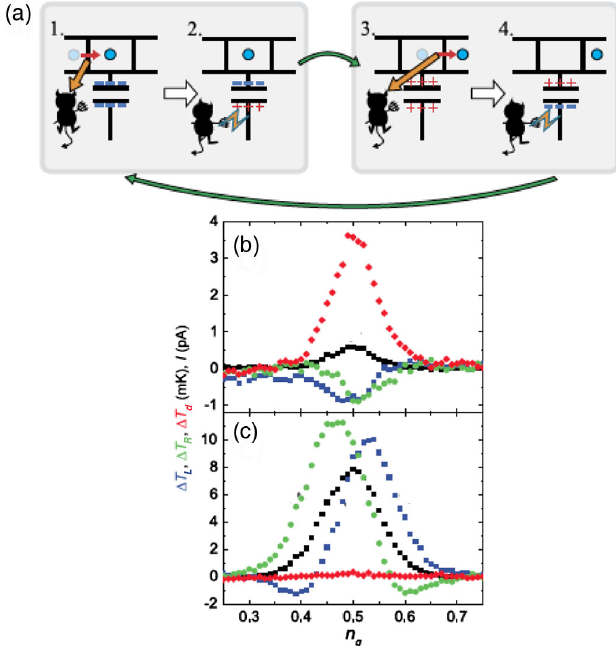
FIG. 15. (a) Principle of the experimental realization of the autonomous Maxwell ’ s demon. The horizontal top row schema- tizes a single-electron transistor. Electrons (blue circle) can tunnel inside the central island from the left wall and outside from the right wall. The demon watches at the state of the island and it applies a positive charge to attract the electrons when they tunnel inside and repels them when they tunnel outside. The systems cools because of the energy released toward the heat bath by the tunneling events, and the presence of the demon makes the cooling processes more efficient. The energy variation of the processes is negative because of the information introduced by the demon. (b) The measured temperature variations of the left (blue line) and right (green line) leads as a function of the external control parameter n when the demon is active and the bath g temperature is 50 mK. We see that at the optimum value, ¼ 1 = 2 , both leads are cooled to about 1 mK and the current n g I flowing through the SET (black line) has a maximum. At the same time, in order to processes information the temperature of the demon (red line) increases a few mK. (c) The same parameters of (b) are measured when the demon is not active. We see that the demon temperature does not change, whereas both leads are now heated by the current I